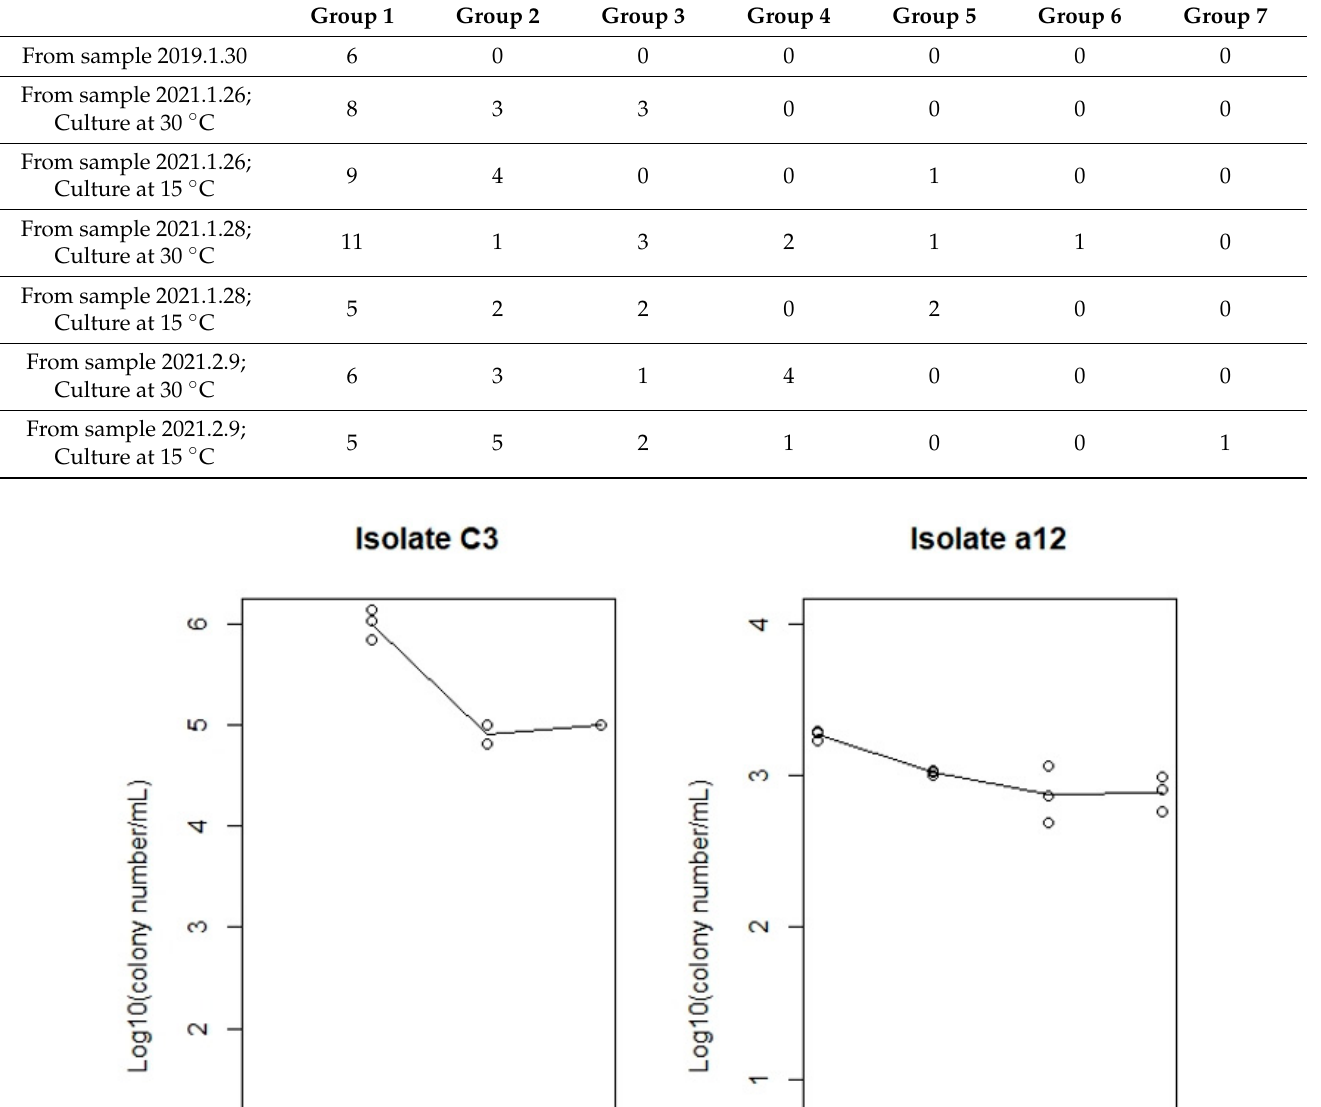
Table 3. Number of isolates in each group.